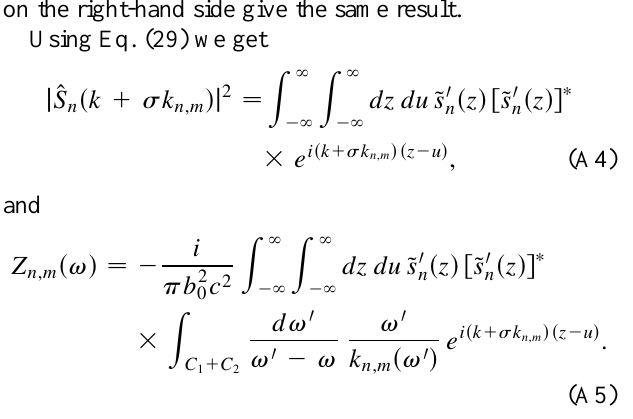
(cid:121) (cid:98) (cid:44) (cid:109) (cid:48)